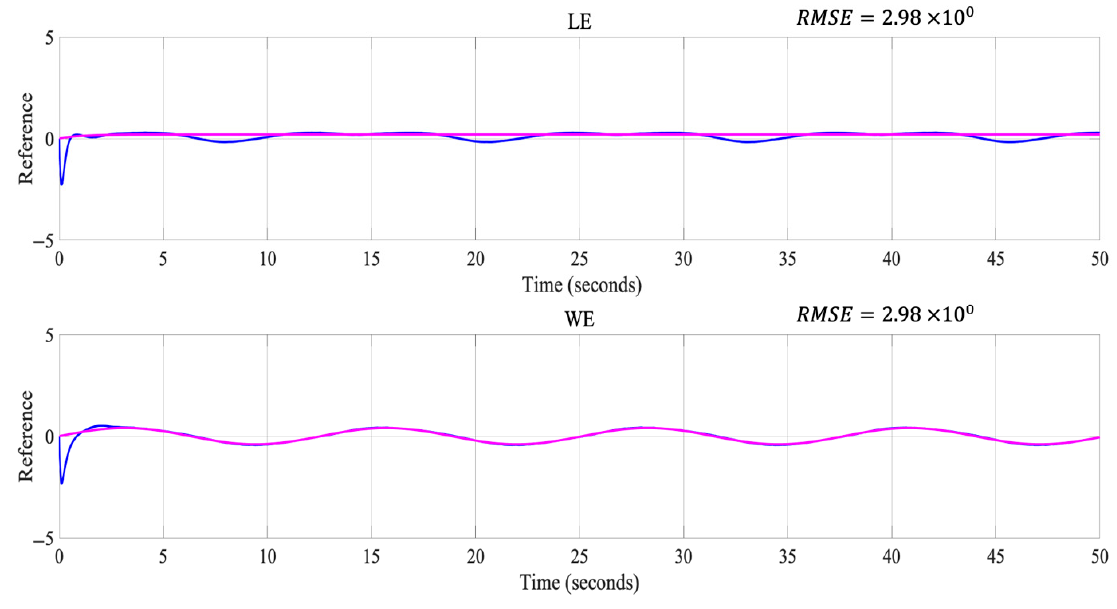
Figure 10. Representation of the best result representing the LE and the WE with disturbance number 1